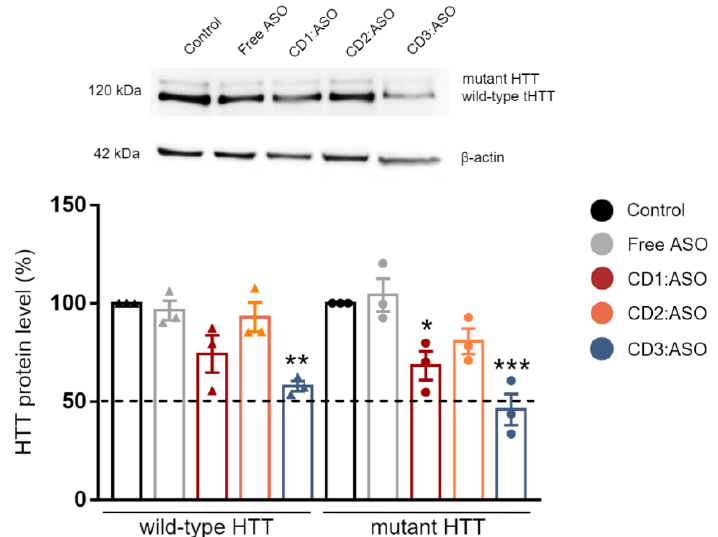
Figure 4. Evaluation of ASO efficacy after transfection with ASO alone or complexed with cyclodex- trins. Representative changes in HTT protein expression (MAB2166) in ST14A cells following 72 h treatment with ASO (100 nM ASO per well). Mean ± S.E.M of 3 technical replicates. * p < 0.05, ** p < 0.01, and *** p < 0.001 compared to control; Two-way ANOVA with Sidak’s post hoc test.